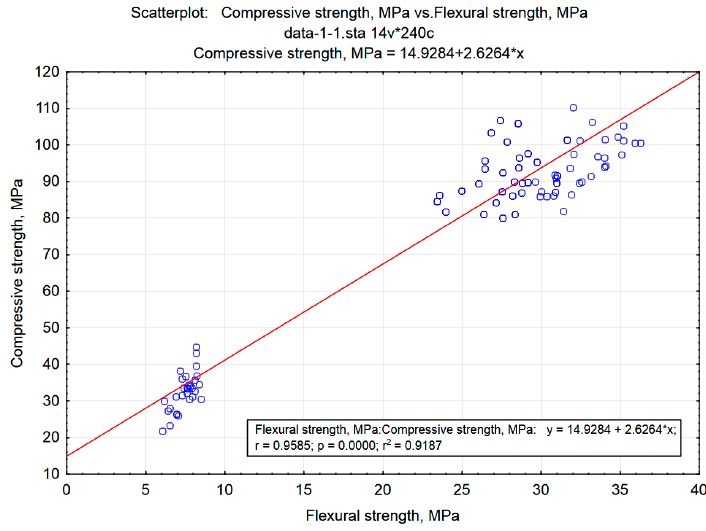
Figure 13. Scatterplot: Compressive strength vs. Flexural strength.